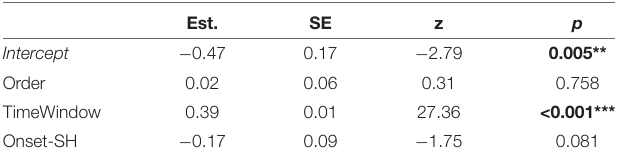
TABLE 3 | Model predictions for all main effects and interactions in fixation accuracy for /s/ vs. / S / onsets, N = 26,750. Est.